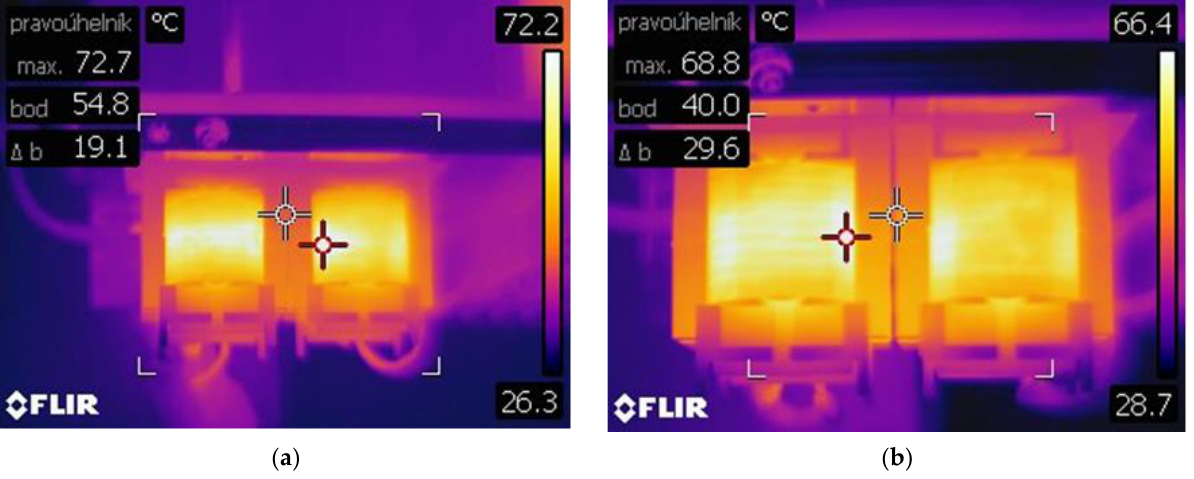
Figure 9. Temperature distribution during converter PFC operation at nominal power equipped with ( a ) inductor with one centered air gap, ( b ) inductor with excluded space around air gap.